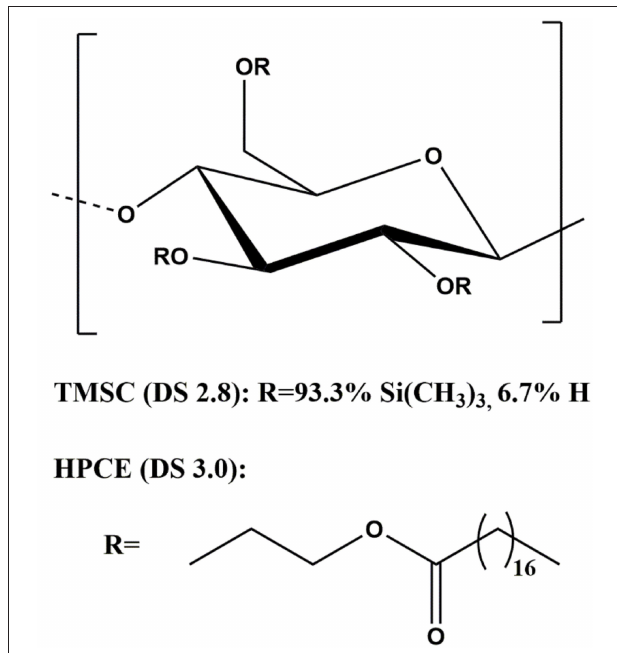
FIGURE 1 | Structure of trimethylsilyl cellulose and hydroxypropylcellulose